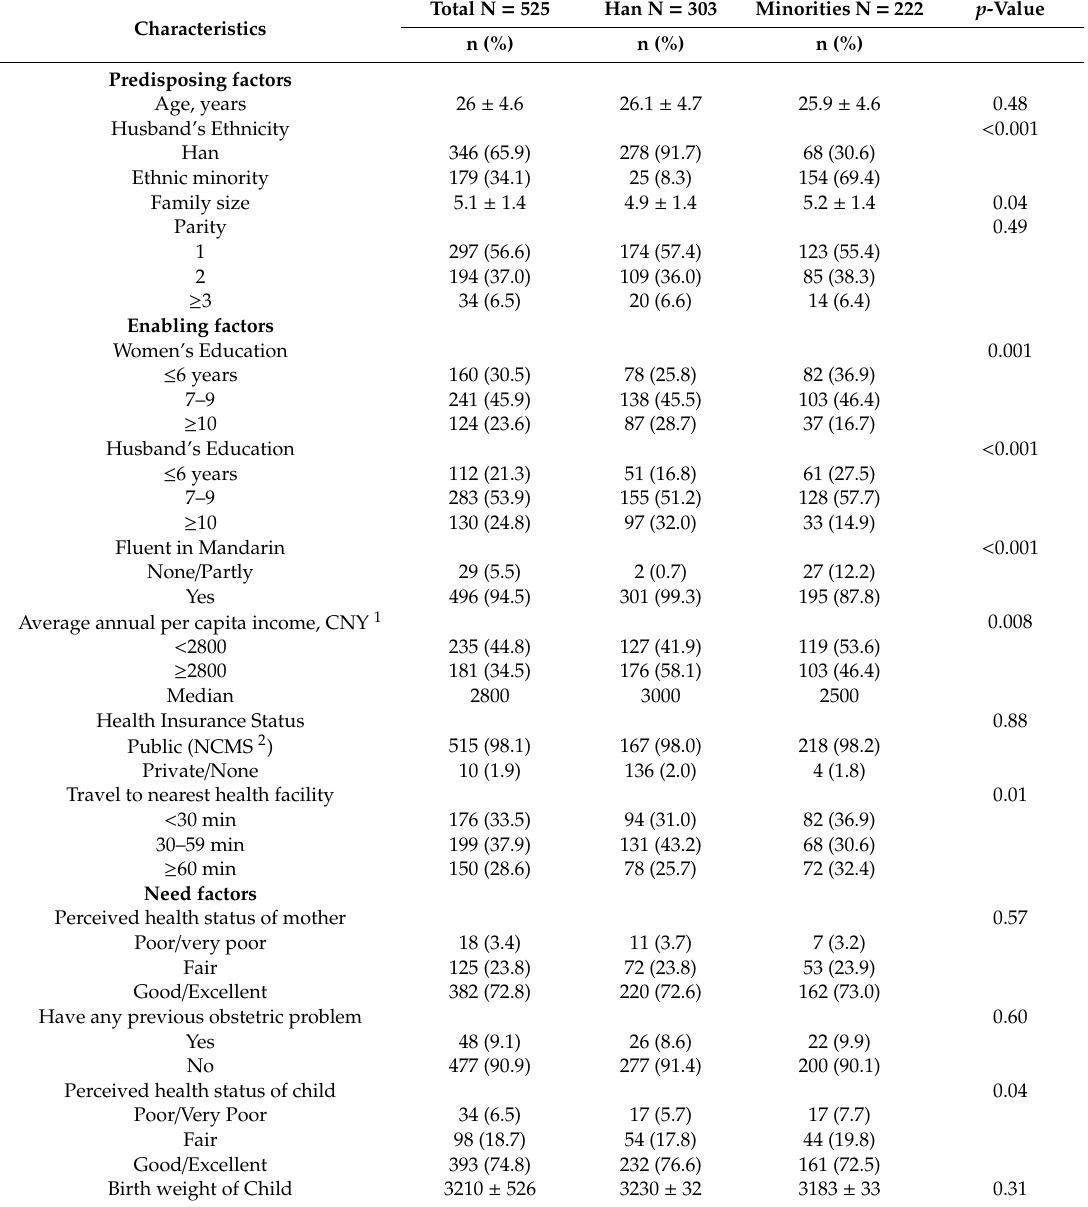
Table 1. Sociodemographic characteristics of study subjects in